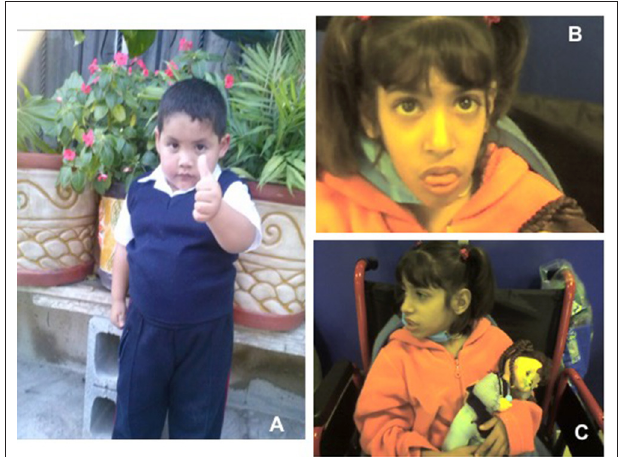
FIGURE 1 | (A) Short stature with overweight in normocephalic school-age boy. Contrast with (B,C) Facial dysmorphisms seen in two twin sisters with LIG4 deficiency. Note prominent middle third of the face, long nose, micrognathia, long ears, jaundice, protruding tongue. (Face photos published with permission from their